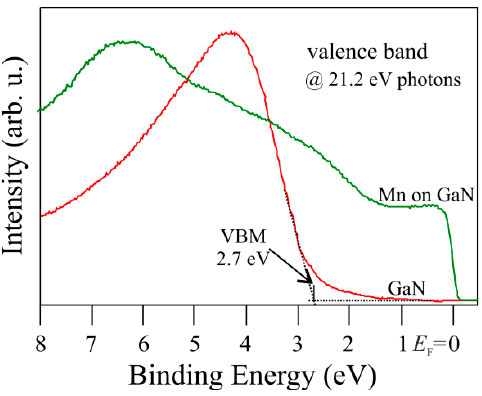
Figure 13. UPS spectra of the valence band for bare and Mn thin ‐ film ‐ covered GaN(0001) surfaces.